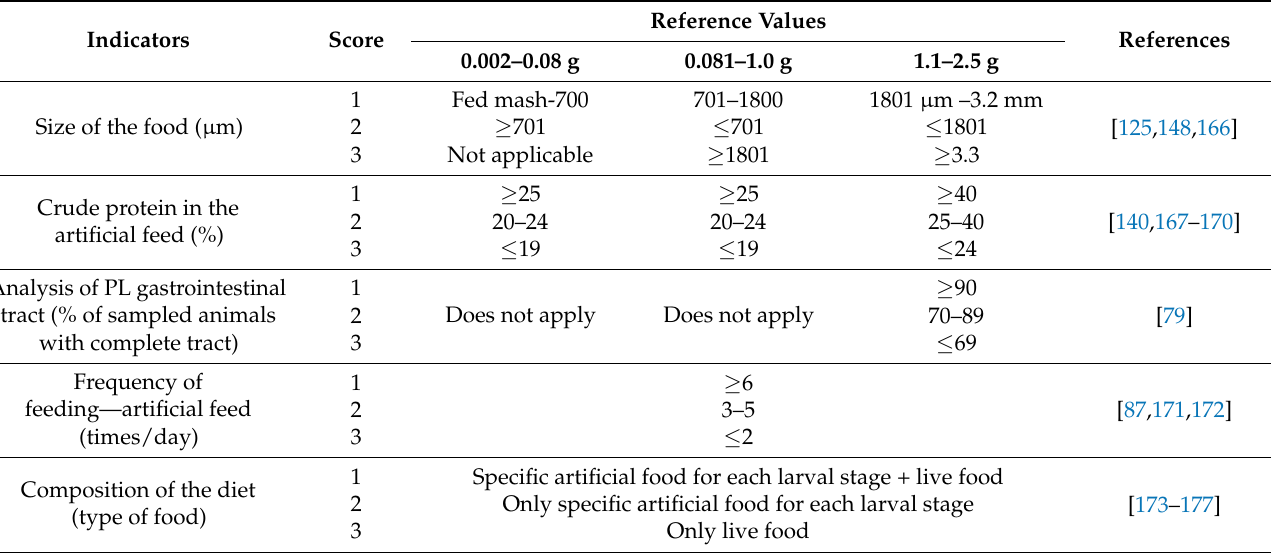
Table 8. Nutritional indicators for larvae and postlarvae of Penaeus vannamei .